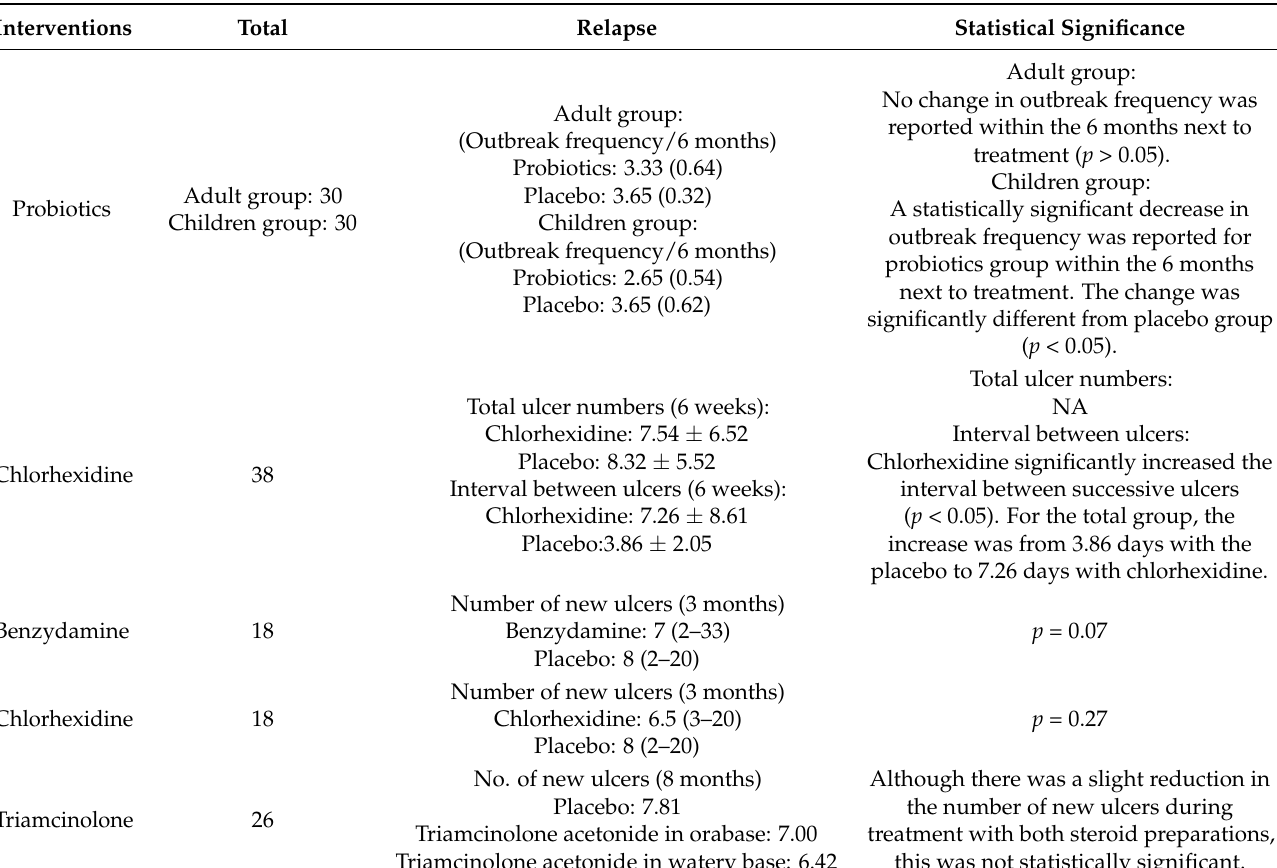
Table 4. Recurrence and statistical